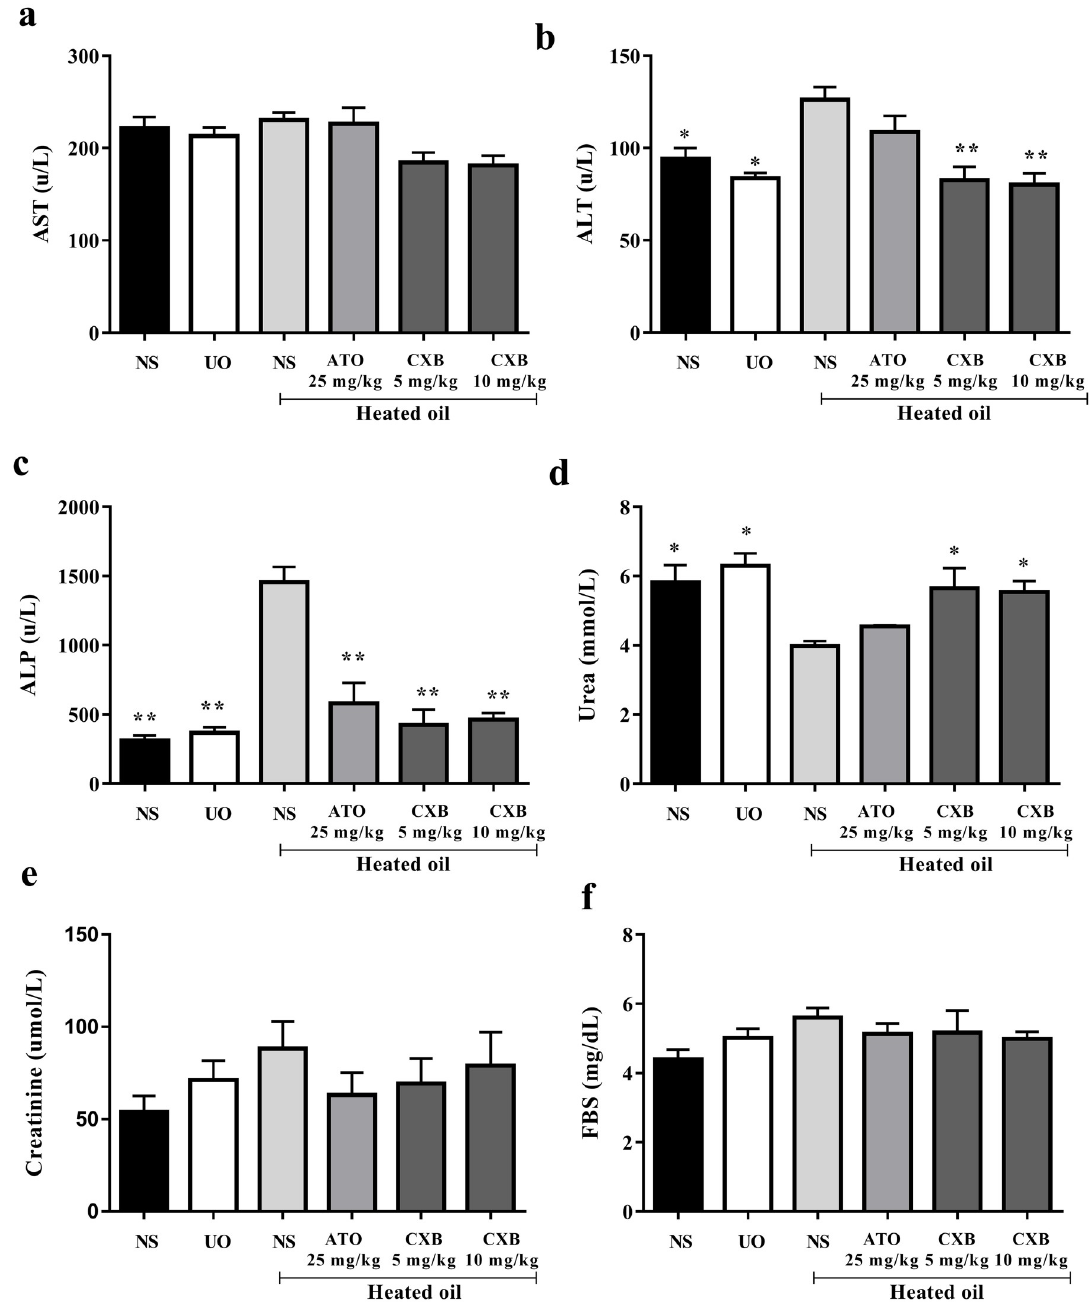
Fig 4. Effect of celecoxib (CXB 5 and 10 mg/kg), atorvastatin (ATO 25 mg/kg) on serum lipid parameters such as (a) AST (b) ALT (c) ALP and (d) urea; and (e) fasting blood sugar in overheated-oil induced hyperlipidaemia in Sprague-Dawley rats. Values are expressed as mean ± SEM (n = 6). The symbols � and �� represents significant differences ( P < 0.05 and P < 0.01 respectively) between treatment groups and heated oil only group (all were compared using one-way ANOVA followed by Newman-Keuls’ post hoc test).